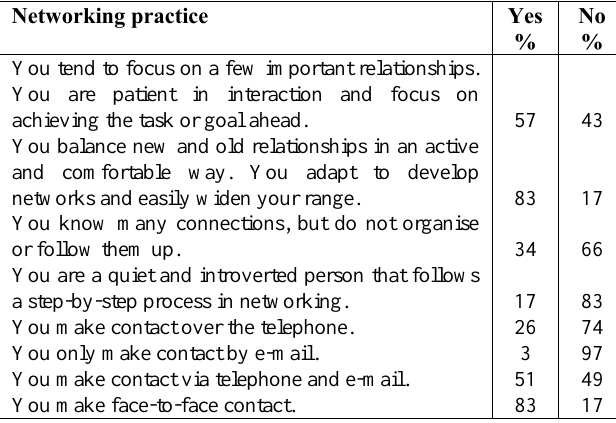
Table 3: Participants’ networking